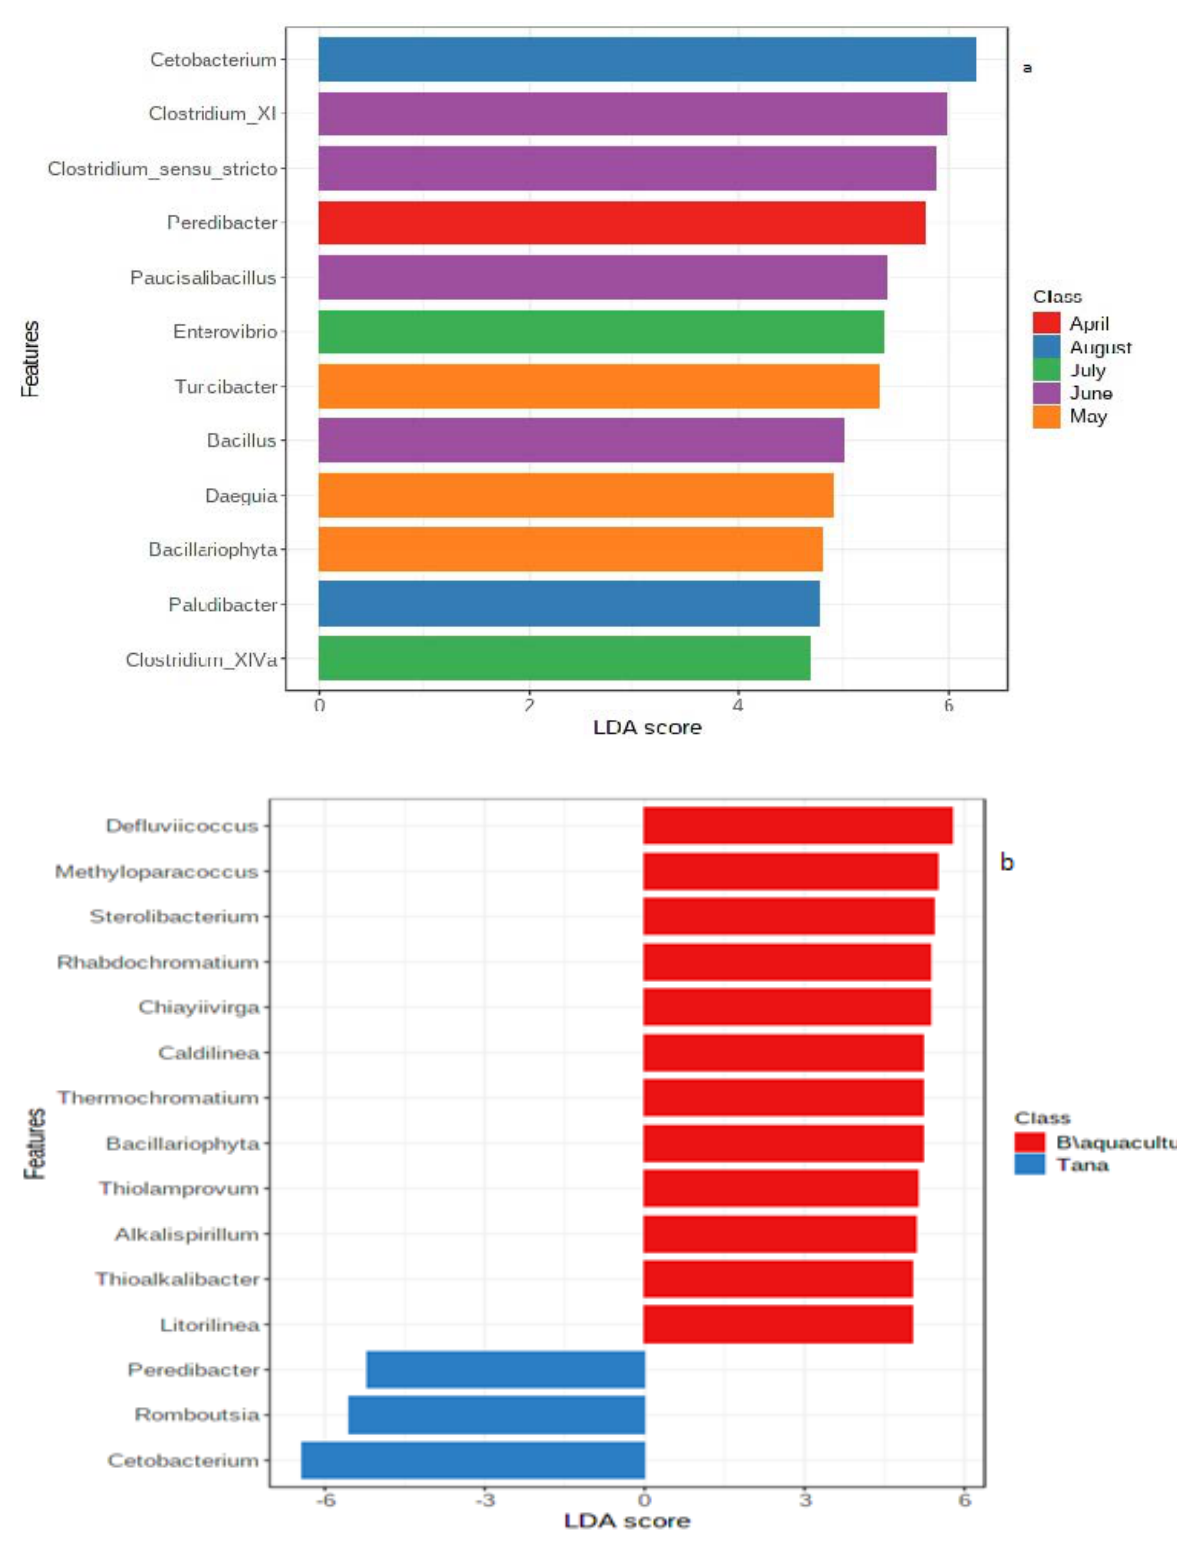
Figure 4. Graphical summary of important taxa identified by linear discriminant effect size (LEfSe) analysis at the genus level. ( a ) Lake Tana samples based on sampling months and ( b ) comparison of Lake Tana and Bahir Dar aquaculture facility centre samples. Horizontal bars represent the effect size for each taxon. Features are considered to be significant based on their adjusted p -value = 0.05.